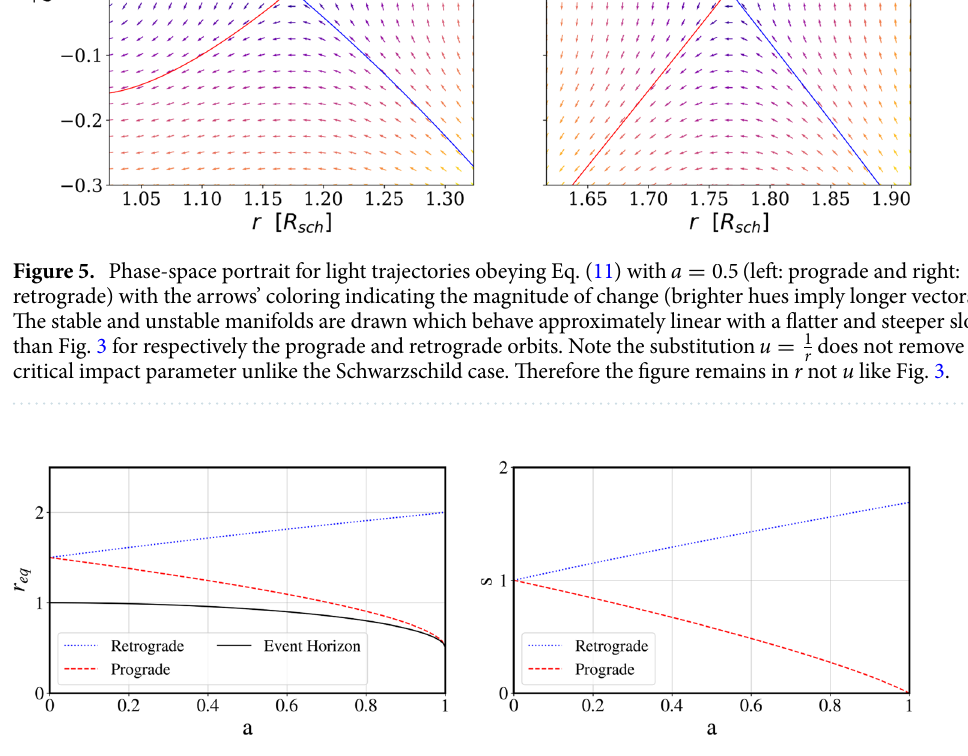
Figure 6. Radii of photon circle, r eq (left), and linear coefficient of Taylor-expansion, s (right). Retrograde orbits (in dotted blue) and prograde orbits (in dashed red). The location of the photon circle is in agreement with 14 , a < 1 , implies that the fixed point will always be a saddle point with while the generic result s > 0 for 0 ≤ 1 the two real fixed points of prograde motion eigenvalues ±√ s and therefore unstable. Notable at a =